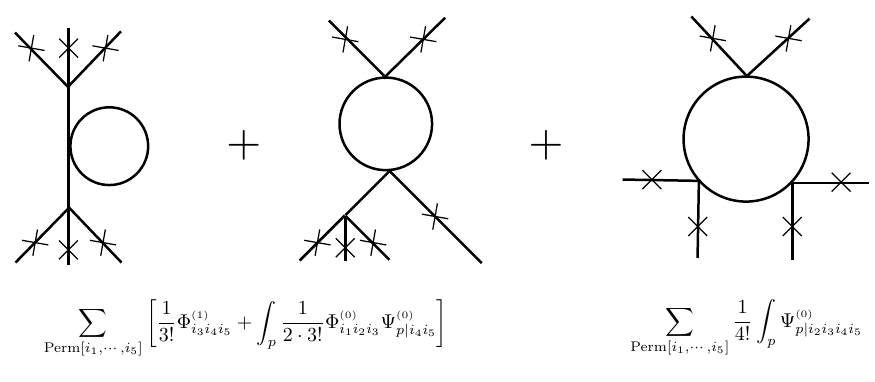
Figure 3 . One-loop six-point amplitude from the one-loop rank-5 off-shell